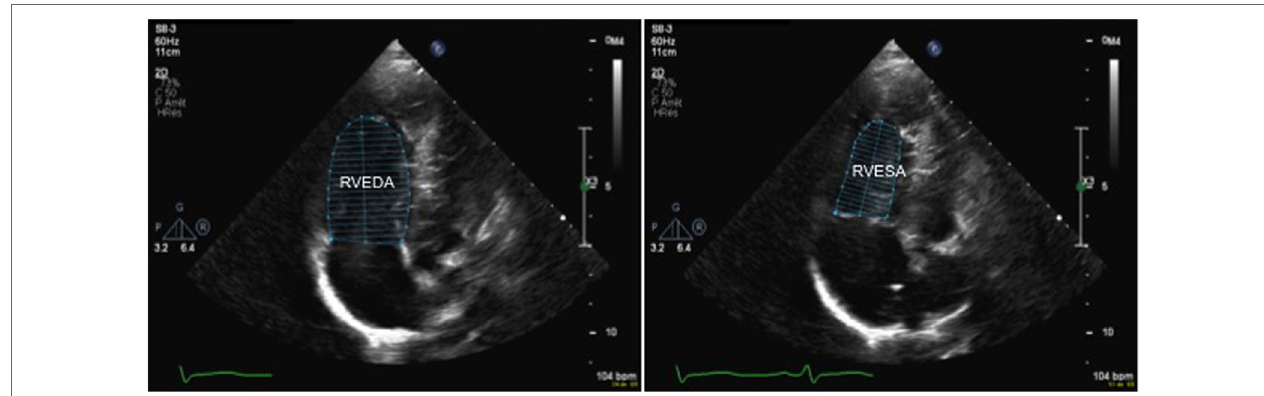
FigURe 9 | 2D echocardiography from an apical four-chamber in a patient with pulmonary hypertension view allowing measurement of the right ventricular fractional area change (FAC) by tracing the endocardial border to obtain the RVEDA and RVESA. A FAC value < 35% is indicative of right ventricular systolic dysfunction. Abbreviations: RVEDA, right ventricular end-diastolic area; RVESA, right ventricular end-systolic